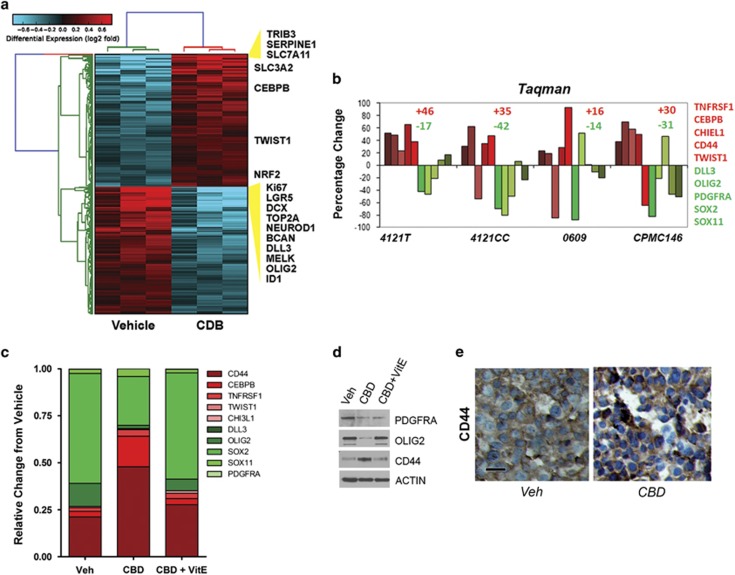
CBD treatment induces ROS-dependent PMT in GBM. (a) CBD treatment results in large-scale differential gene expression. Gene expression as log 2 fold changes, normalized between vehicle- and CBD- (2 μM) treated groups for each cell line, are shown for 2107 protein coding and 243 noncoding RNAs (fold >1.25 and false discovery rates (FDR)-adjusted t-test, P<0.1). Predicted crucial regulatory factors are indicated on the right of the graph. Red depicts upregulation, while blue indicates downregulation. (b) Taqman validation of several PN (indicated in green) and MES (in red) markers in three additional GSC lines and an acutely dissociated patient tissue (CPMC146) confirm CBD-induced PMT. (c) Taqman analysis of PN and MES markers in 3832 cells treated with CBD or CBD+VitE. Results were normalized to Rab14 expression levels. (d) The 3832 GSCs treated with CBD±VitE were subjected to western blot analysis using the indicated antibodies to detect PN (Olig2) and MES (CD44) markers. (e) IHC analysis of GBM xenograft tissue sections from mice treated with vehicle or CBD (intraperitoneally 15 mg/kg, 5 days per week). Tumor tissue was harvested at 29 days after tumor implantation. Bar=50 μm